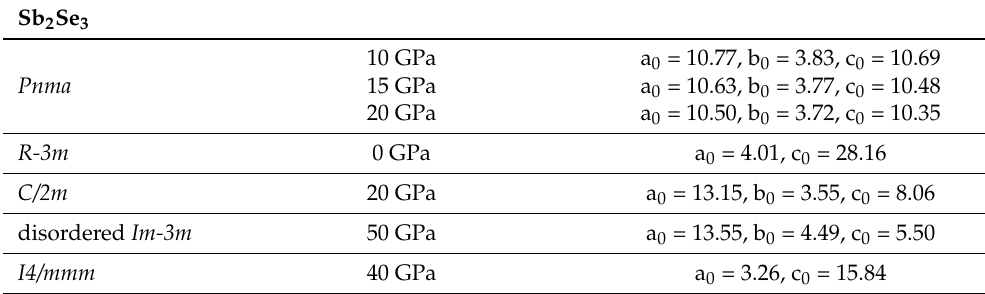
Table A3. Theoretical estimation (PBEsol) of the lattice parameters of the Sb 2 Se 3 compound, for the different structural phases that are both energetically and dynamically stable within the range of studied pressures (presented in units of